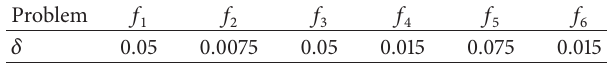
Table 1: Settings for parameter 𝛿 in LDIW-PSO.